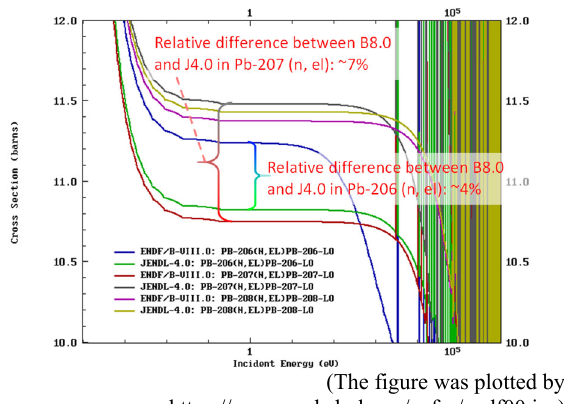
Fig. 8. Elastic scattering cross sections of lead’s nuclides.